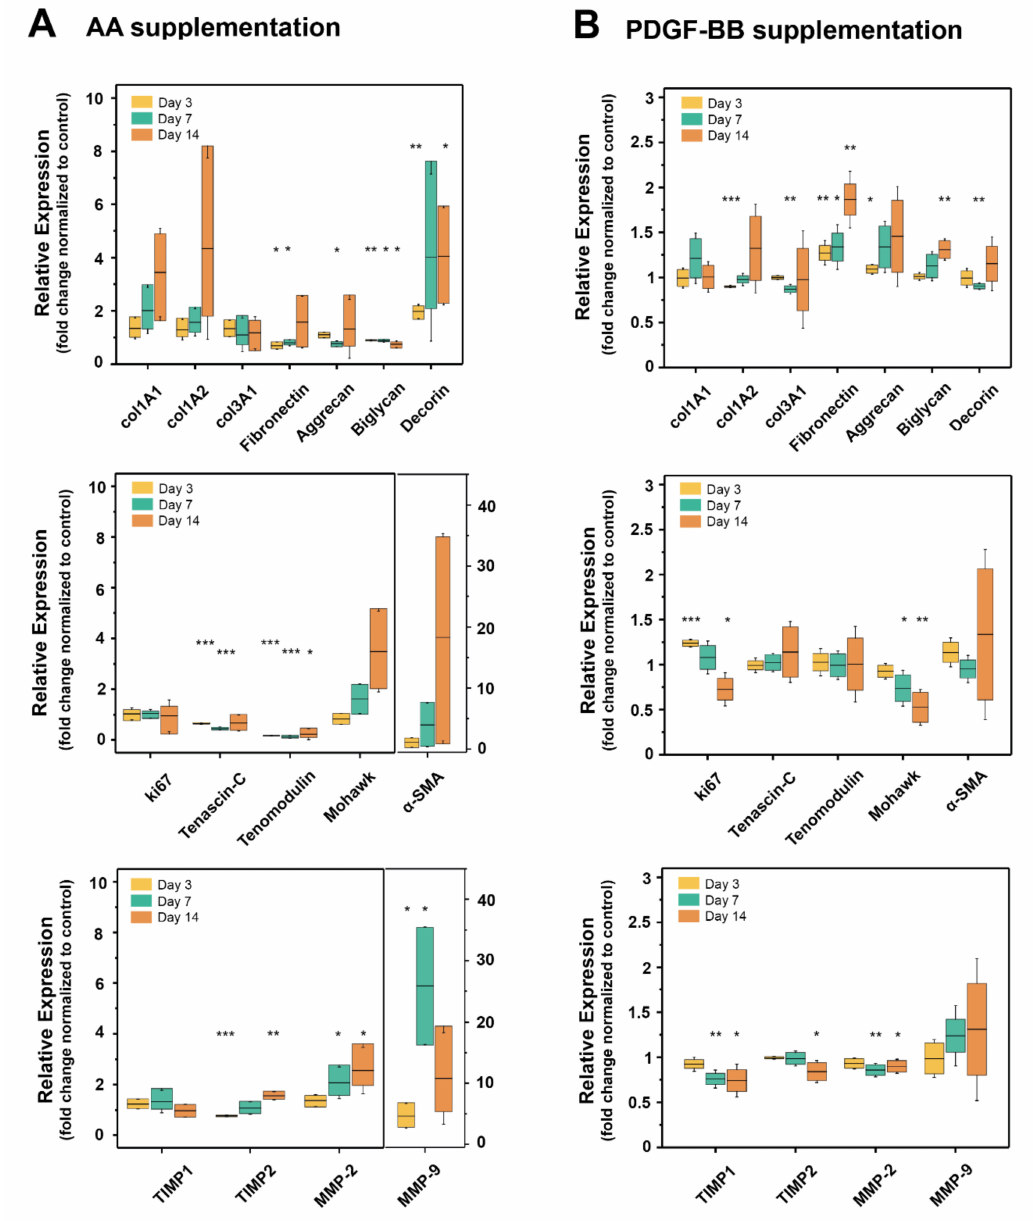
Figure 3. Gene expression of tenocytes supplemented with AA or PDGF-BB over 14 days in 2D cell culture. ( A ) Box-plots of time-dependent (day 3, 7 and 14) relative gene expression in tenocytes supplemented with AA (50 µ g / mL), normalized to non-stimulated tenocytes and ( B ) box-plots of time-dependent (day 3, 7 and 14) relative gene expression in tenocytes supplemented with PDGF-BB (25 ng / mL), normalized to non-stimulated tenocytes. In the experiments with AA, tenocytes isolated from three di ff erent rabbits were used (biological replicates n = 3), while for PDGF-BB experiments, cells from four di ff erent rabbits were used (biological replicates n = 4). Technical replicates in cell culture were performed in triplicate and in PCR experiments in duplicate. Significant di ff erences were based on unpaired t -tests for each time point (whiskers on the box-plots represent standard deviation, * p < 0.05, ** p < 0.01, *** p <